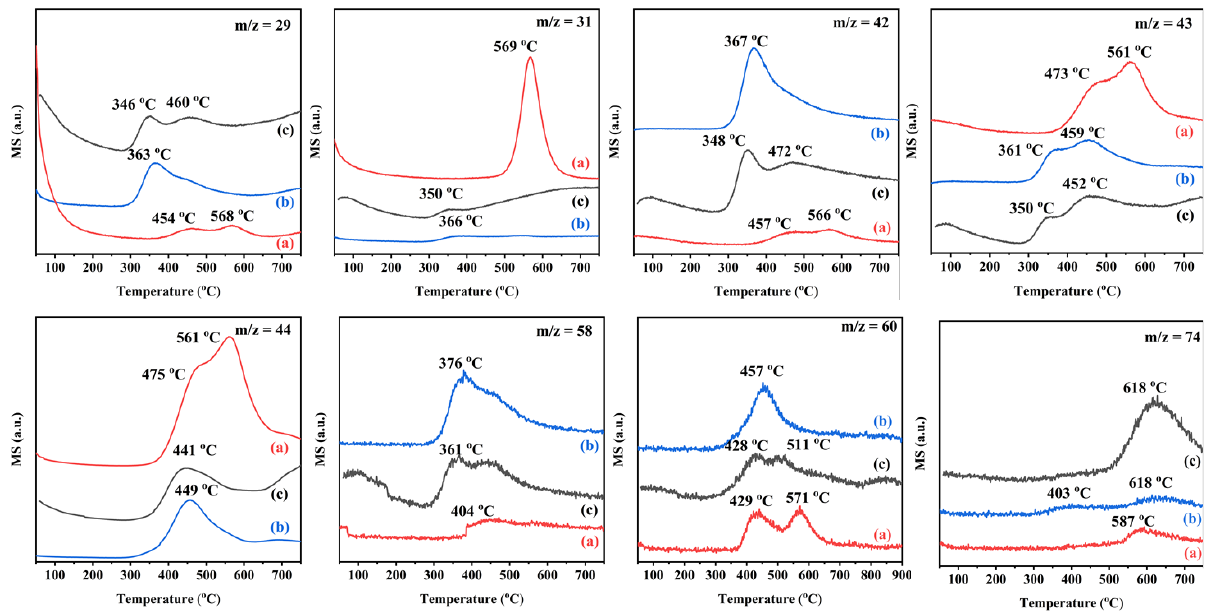
Figure 11. Ethyl acetate-TPD profiles of ( a ) 0.34AuPd 2.09 /TiO 2 , ( b ) 0.33Pd/TiO 2 , and ( c ) 0.36Au/TiO 2 .